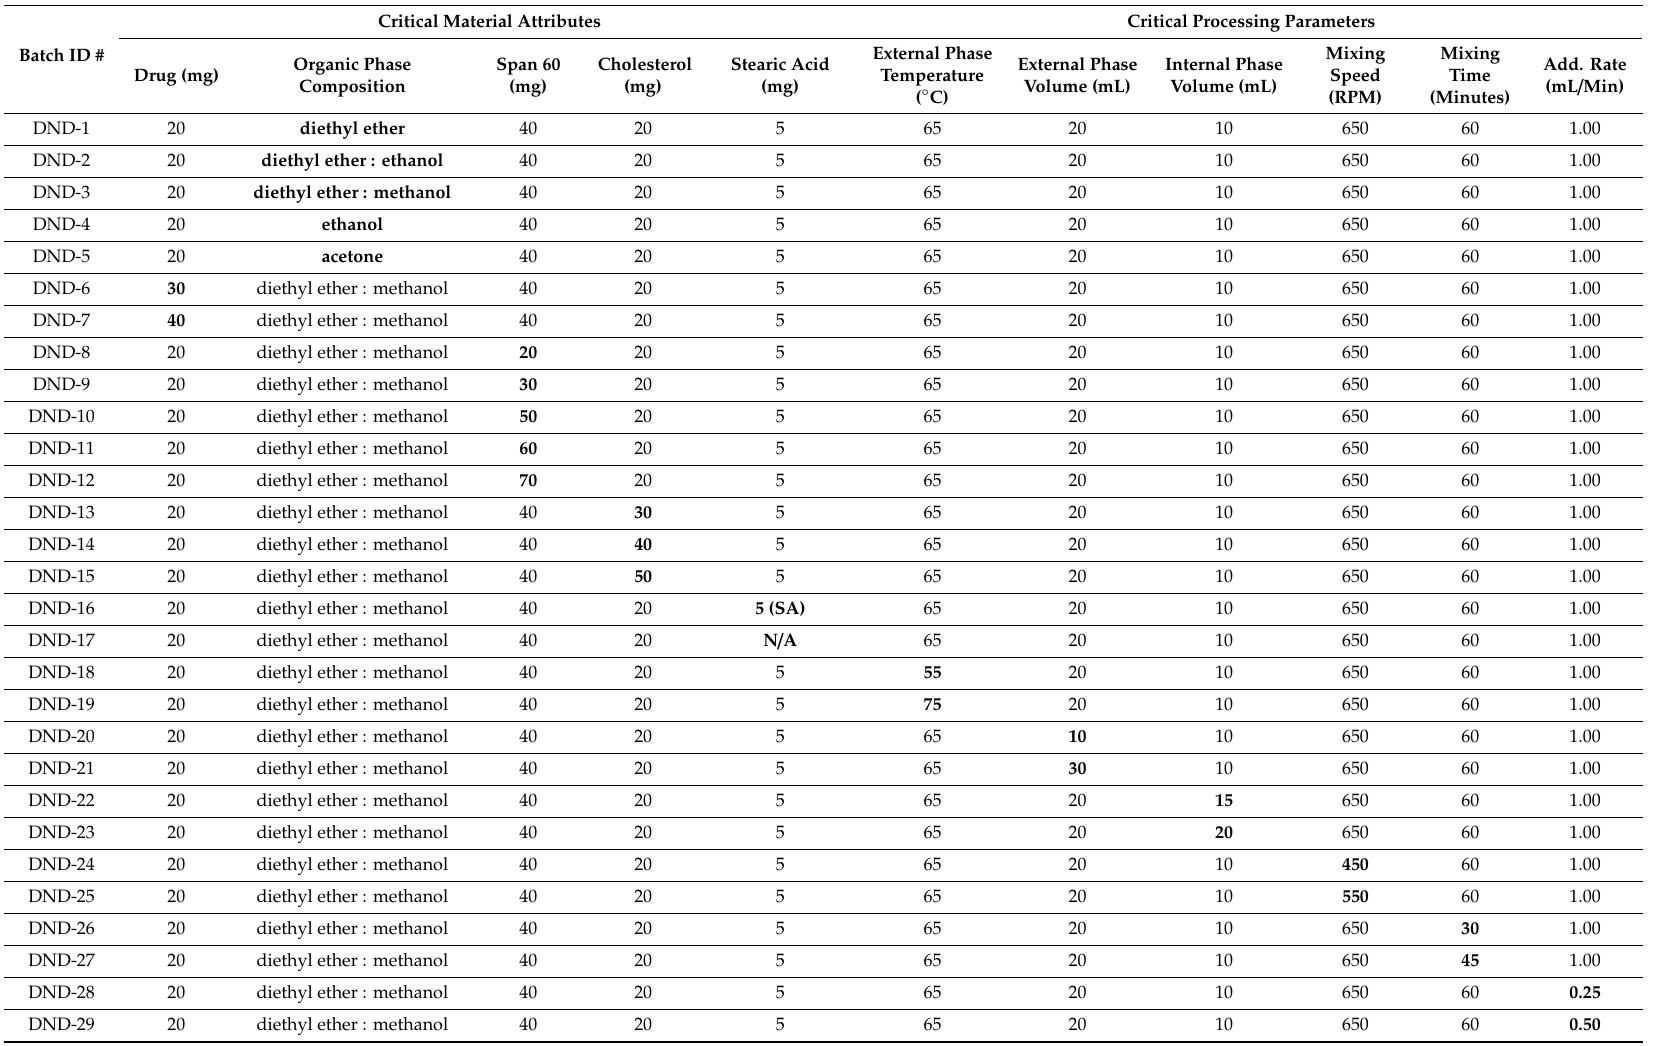
Table 2. Quality by Design (QbD)—Niosome Batch Experimental Design